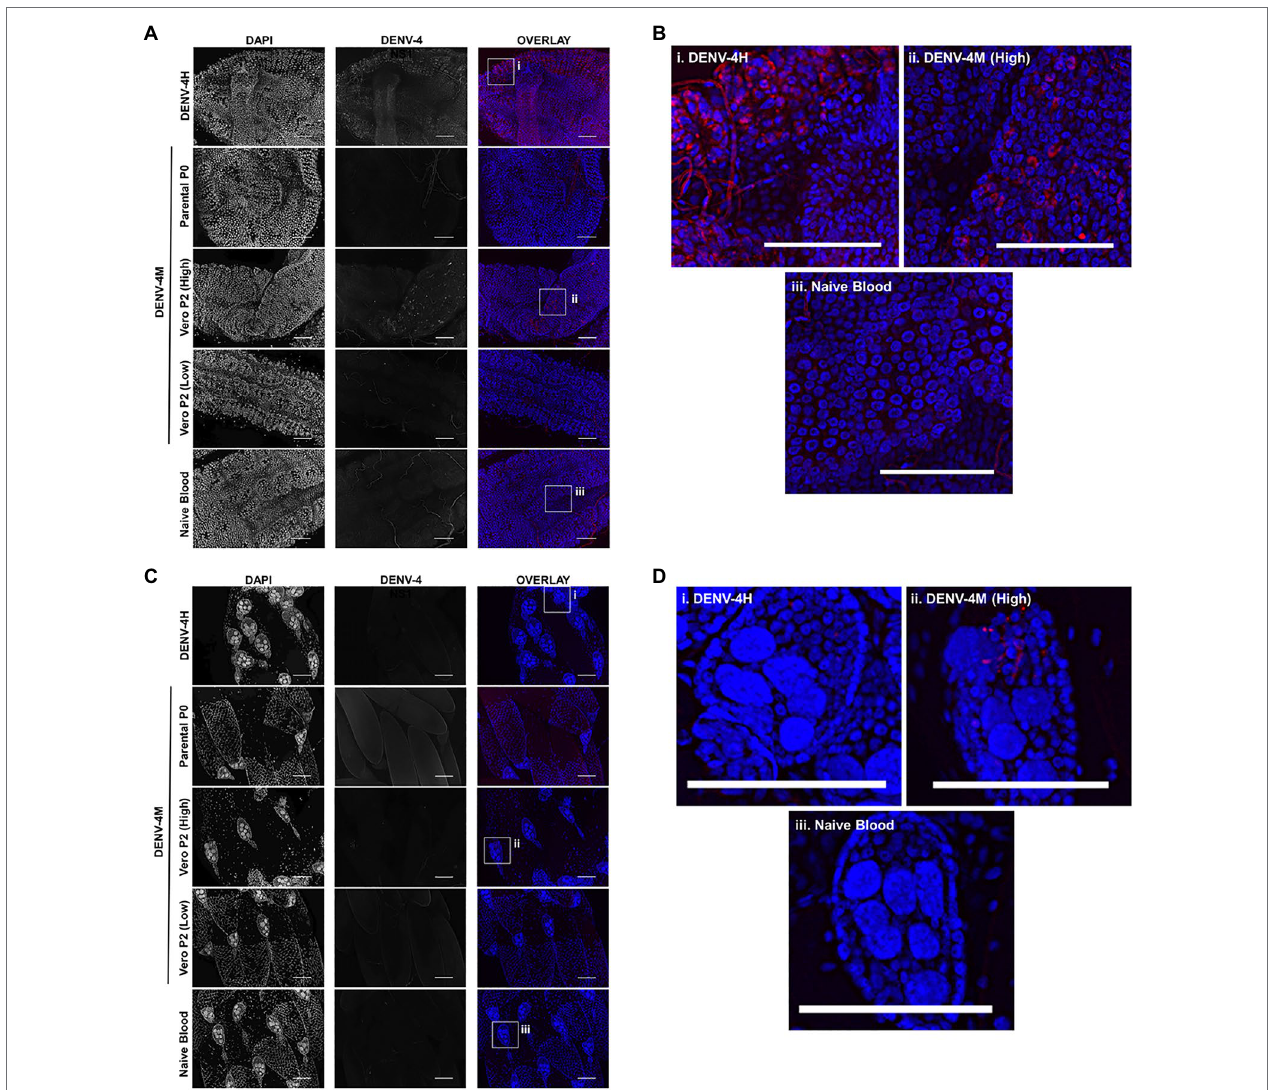
FIGURE 6 | DENV-4M replicates in the midgut and ovary at 14 dpi. Adult female ORL mosquitoes were fed a blood meal containing DENV-4H (5 × 10 6 PFU/ml), Parental P0 DENV-4M (3 × 10 4 PFU/ml), Vero E6 P2 DENV-4M (high titer: 7 × 10 6 PFU/ml, low titer: 4 × 10 3 PFU/ml), or naive blood without virus. On day 14 post- infection, midguts (A,B) and ovaries (C,D) were dissected, and virus replication was visualized by NS1 IFA (red, middle column) with DAPI DNA counterstain (blue, left column). (B) and (D) are insets chosen to show the NS1 signal in virus positive conditions, compared to the naive blood negative control. Representative images were chosen from at least two independent replicates. Scale bar = 100 μ